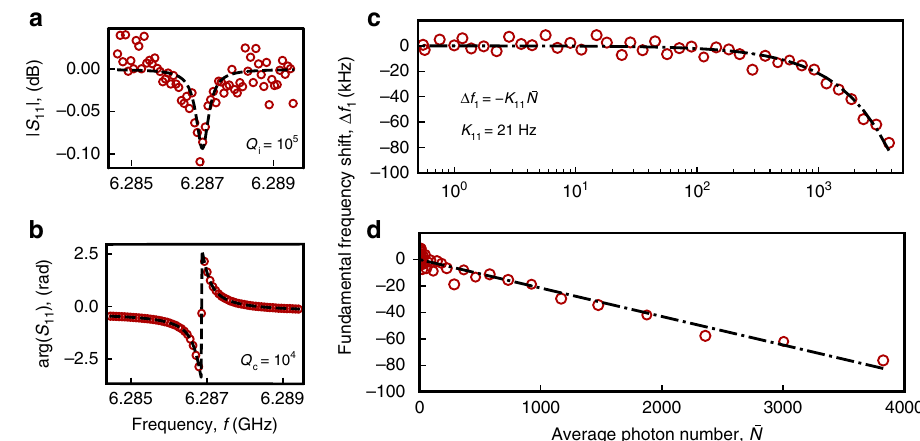
Fig. 3 Measurement of the nonlinearity in grAl resonators. Typical measured amplitude (normalized by the sample holder response) ( a ) and phase ( b ) of the re fl ection coef fi cient S 11 for resonator grAl#1 (see Fig. 2a). We typically observe internal quality factors of the resonators in the range of 10 5 . c , d We plot the measured shift of the fi rst resonant frequency vs. circulating photon number (cid:1) N in logarithmic and linear scale, respectively. The corresponding self- Kerr coef fi cient extracted from the linear fi t K 11 /2 π = 21 Hz. The measured frequency shift remains linear versus photon number for all samples measured below bifurcation, which is consistent with the fact that the estimated circulating current never exceeds ~1% of the critical current